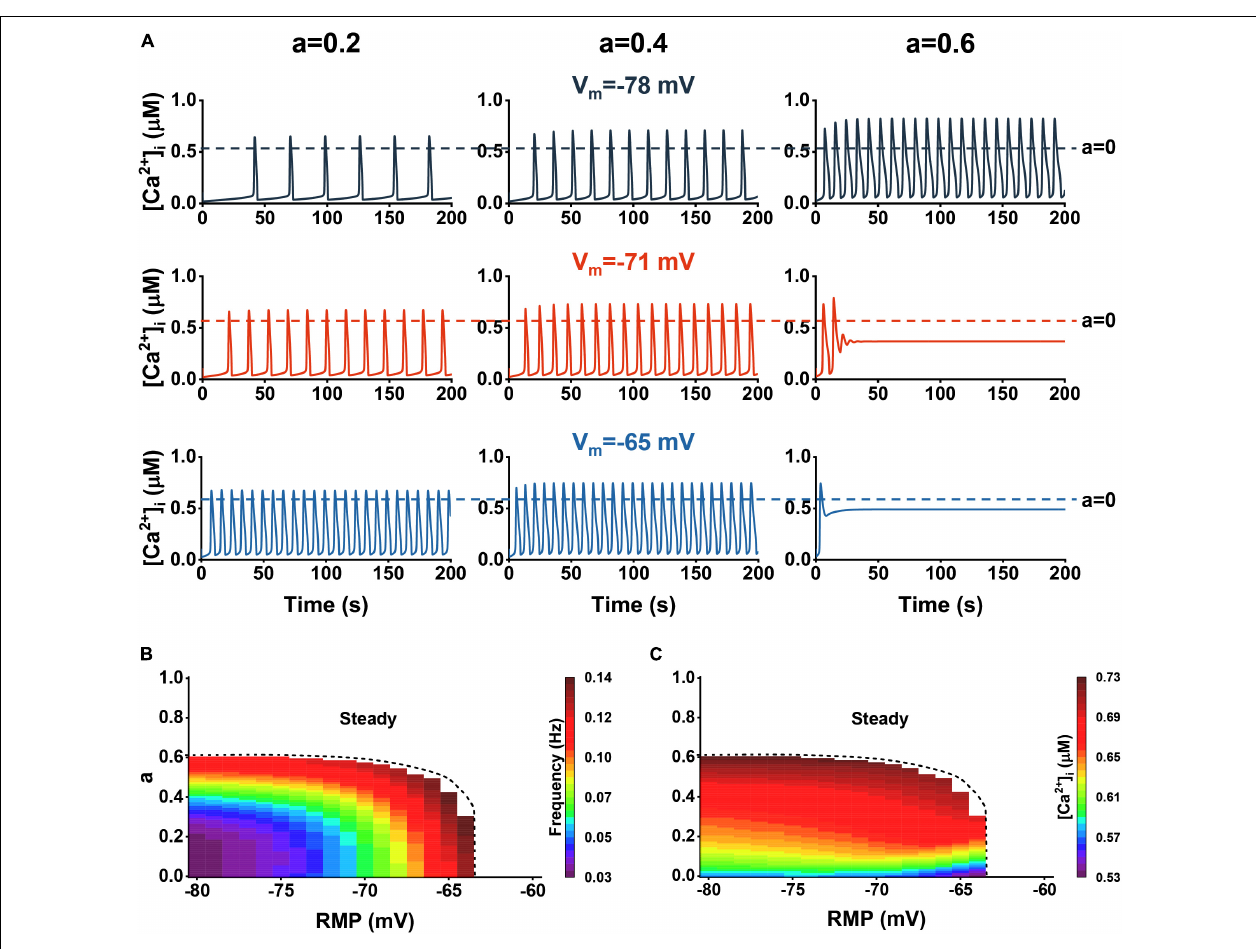
FIGURE 6 | The influence of A β on Ca 2 + dynamics with RMP. (A) Representative traces of Ca 2 + dynamics within the three different A β levels (0.2, 0.4, and 0.6) at different V m : –78, –71, and –65 mV. (B) The frequency of Ca 2 + signals vs. A β levels and RMPs. (C) The amplitude of Ca 2 + signals vs. A β levels and